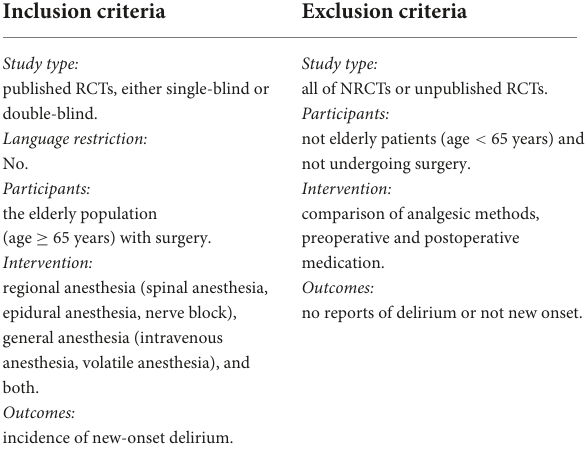
TABLE 1 The inclusion and exclusion